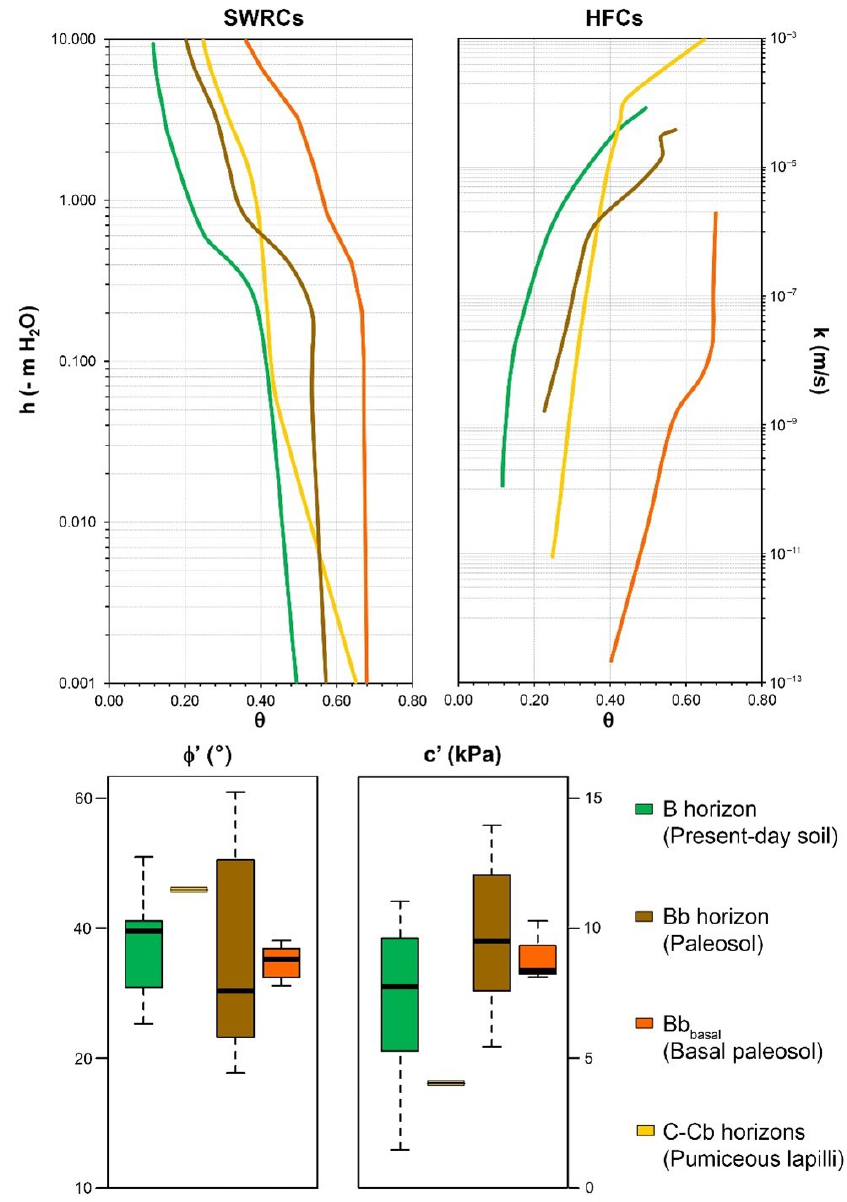
Figure 3. Main hydro-mechanical properties of soil horizons characterizing ash-fall pyroclastic soil coverings of Sarno and Lattari Mountains. Data were obtained by in situ and laboratory tests [59,75]. Key to symbols: SWRCs = soil water retention curves; HFCs = hydraulic conductivity functions; φ ’ = effective friction angle; c’ = effective